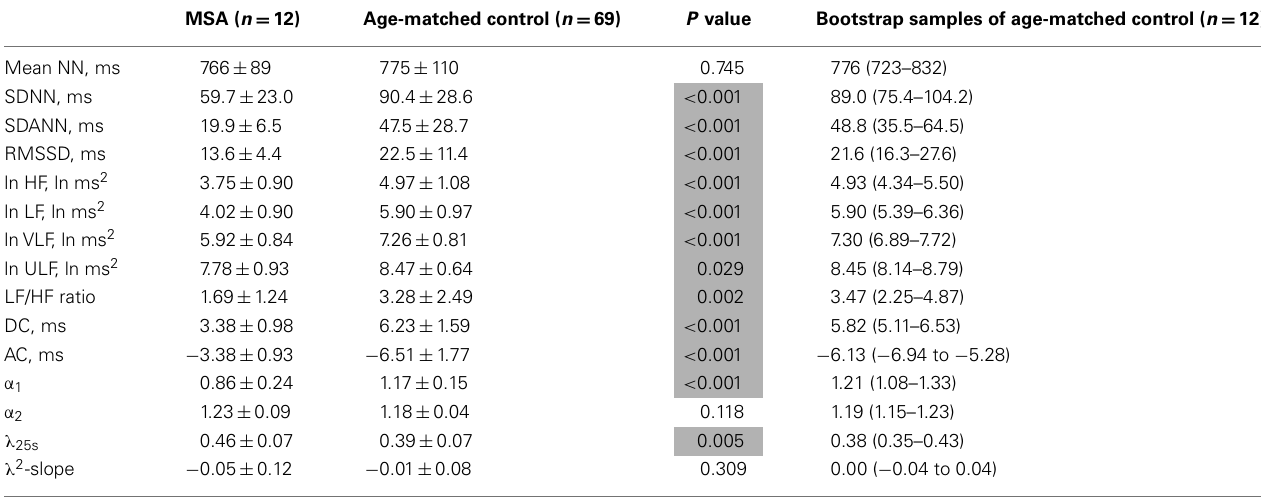
Table 3 | Heart rate variability measures in patients with multiple system atrophy (MSA) and age-matched controls.